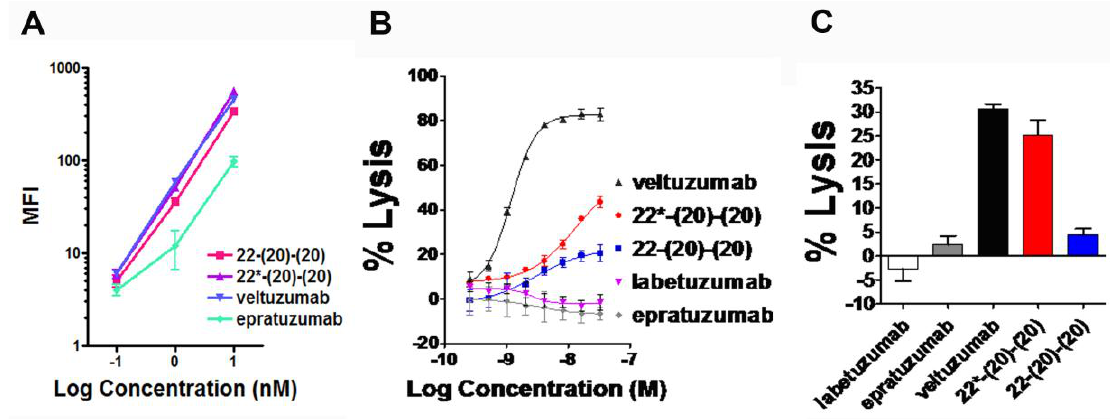
Figure 4. Comparison of target cell binding ( A ), CDC ( B ) and ADCC ( C ) of 22*-(20)-(20), 22-(20)-(20) with parental (epratuzumab, veltuzumab) and isotype-control (labetuzumab) antibodies. Adapted from Reference